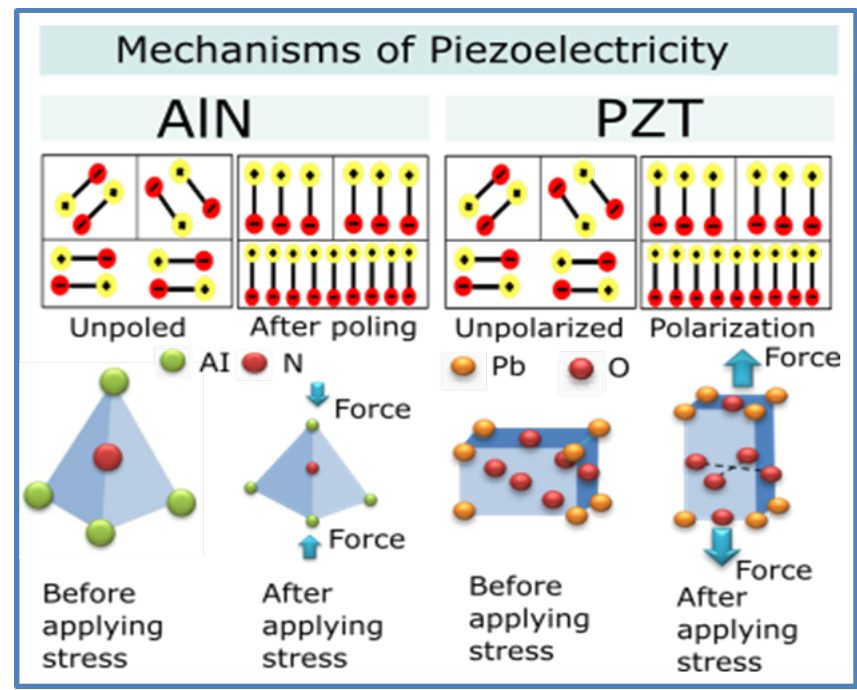
Figure 3. Scheme of mechanisms of piezoelectricity in inorganic materials.